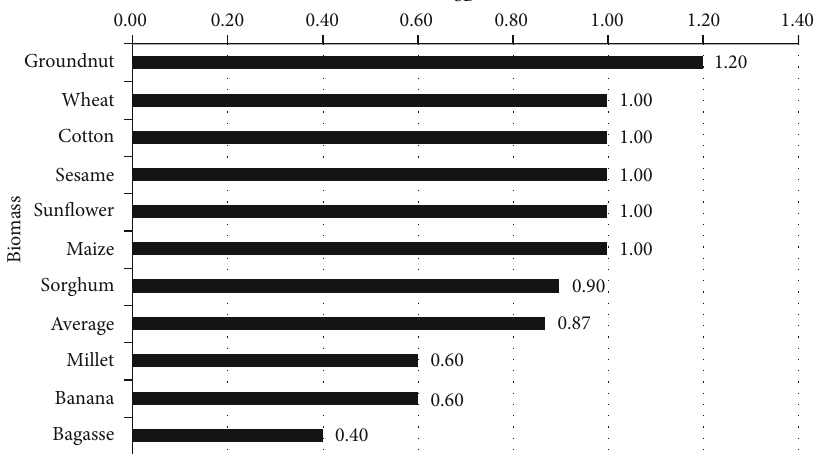
Figure 5: SB at ER = 0 : 15 for di ff erent types of biomass.